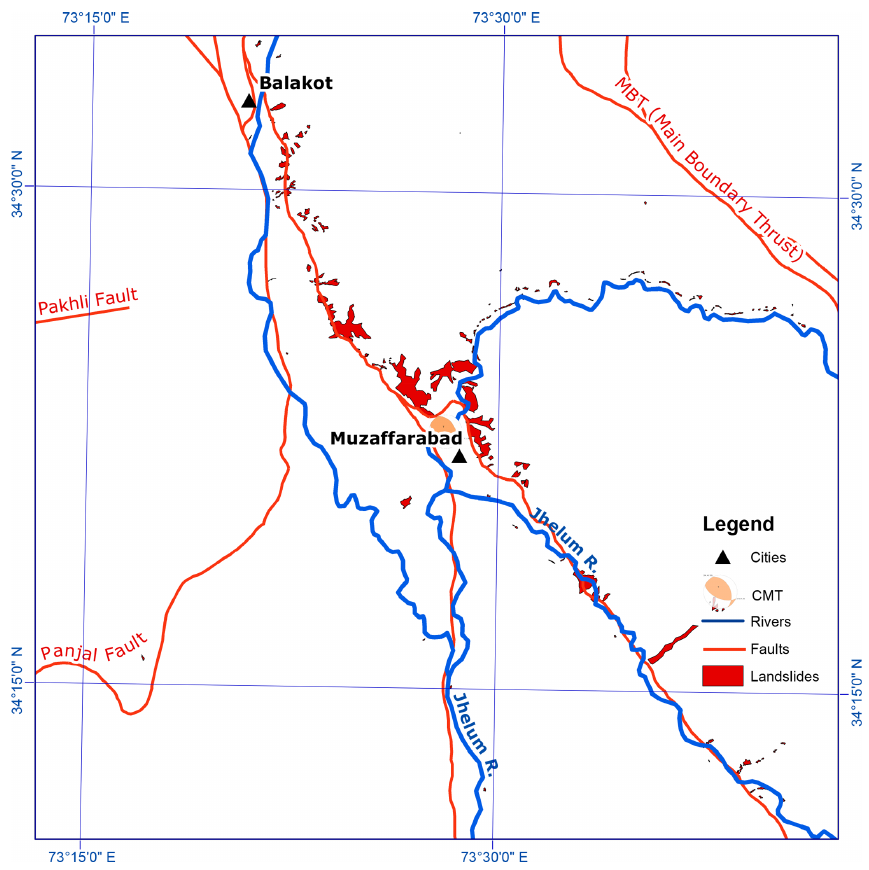
Figure 3. Co-seismic landslides inventory was developed by the Humanitarian Information Center (HIC), a subsidiary organization of the United Nations Office for Coordination of Humanitarian Affairs (OCHA), which was reported by Shafique et al. (2008).